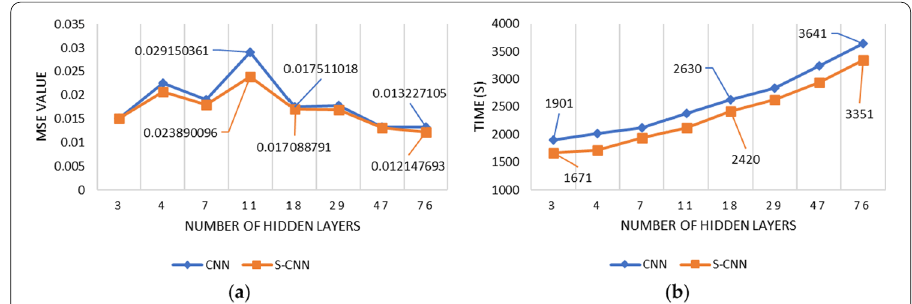
Fig. 10 Comparison of CNN and S-CNN with scenario 2: a MSE; b Processing time